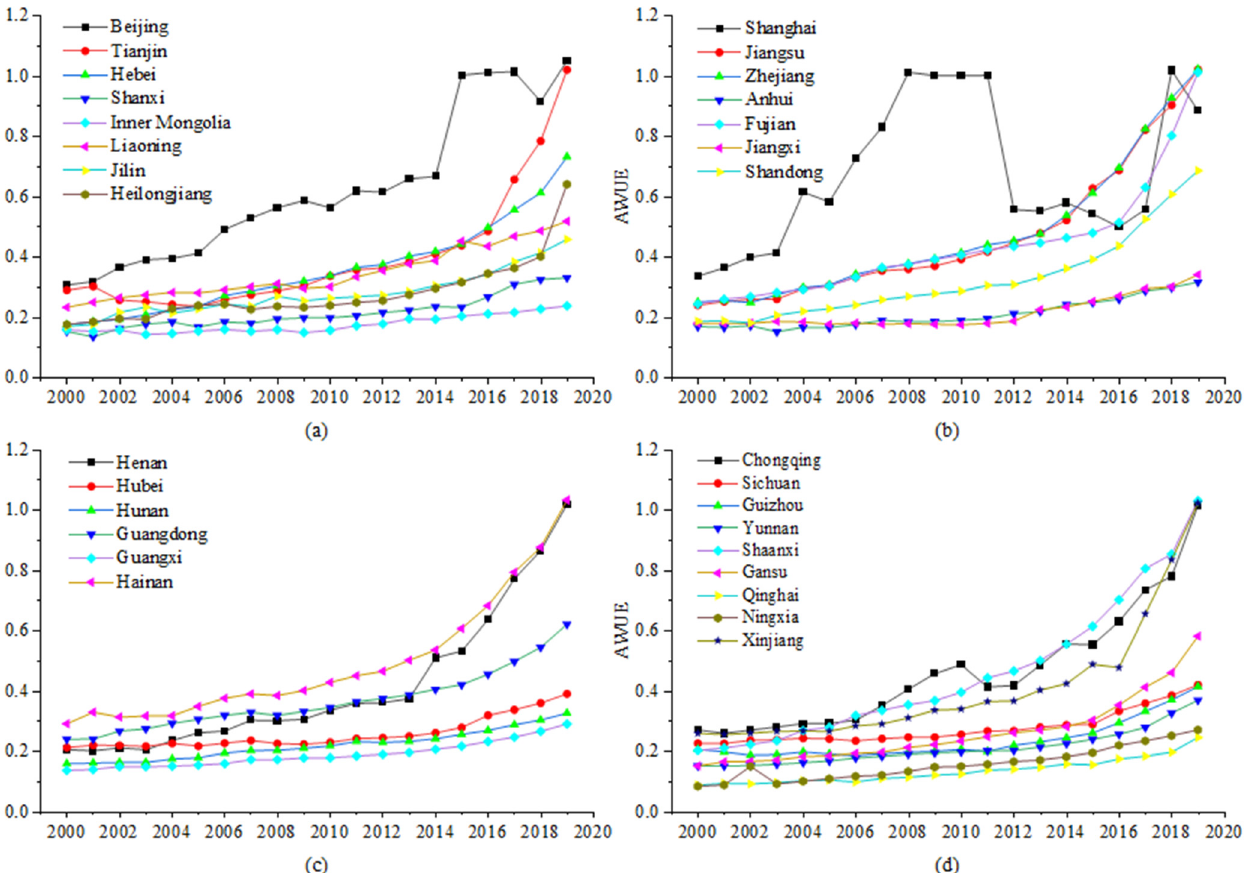
Figure 2. Temporal trends of provincial agricultural water use efficiency (AWUE) in China from 2000 to 2019. The above four charts are listed separately according to the geographical location of the province within ( a ) North China (8 provinces), ( b ) East China (7 provinces), ( c ) South China (6 provinces), and ( d ) West China (9 provinces).